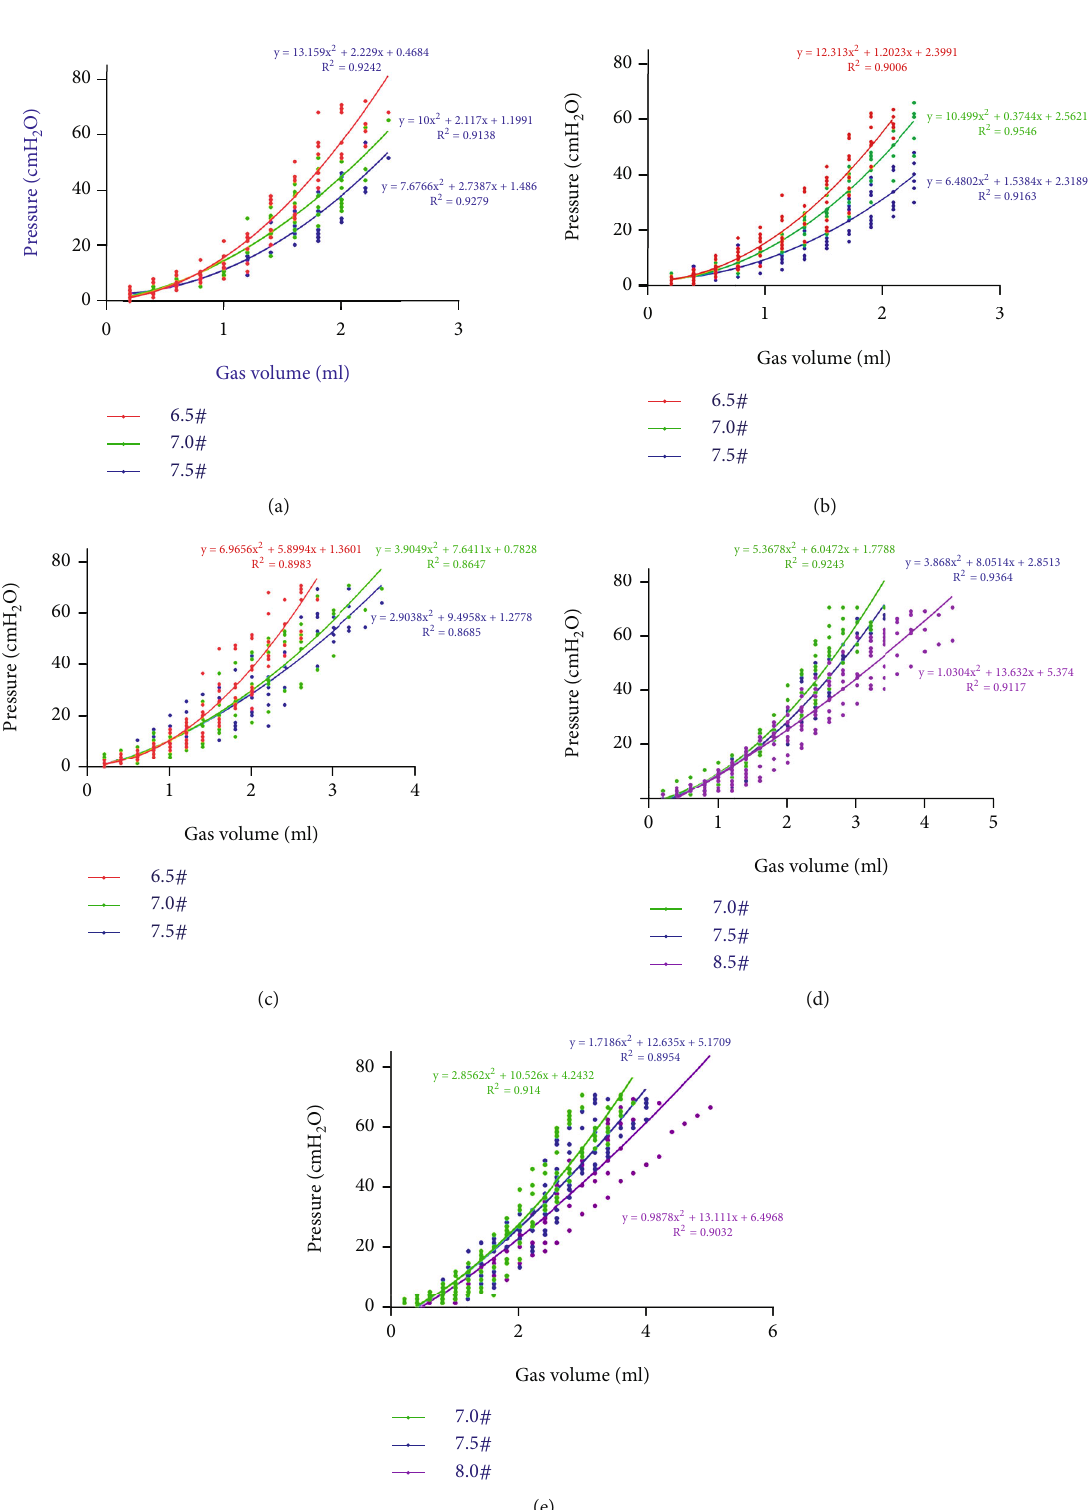
Figure 2: Relationship between endotracheal tube cu ff pressure and air injection volume in groups (a) –